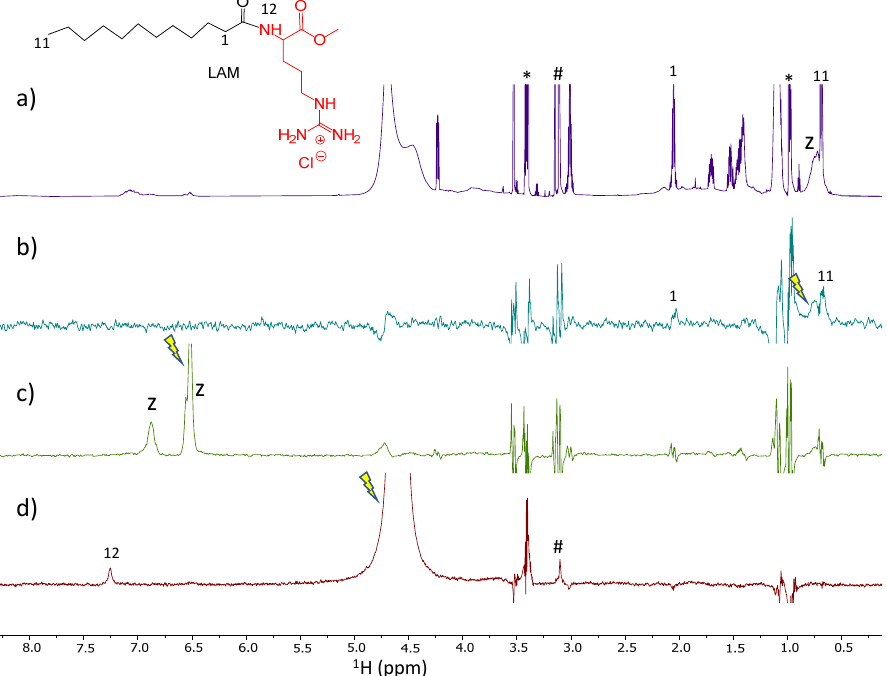
Figure 6. Spectra of LAM and zein mixture. ( a ) 1 H NMR, ( b , c ) STD off-on spectra with saturation at 0.82 and 6.6 ppm, respectively and ( d ) WaterLOGSY (mix. 500 ms). The arrow indicates the signal that is selectively on-saturated in STD spectra or selectively inverted in waterLOGSY. The assignment is provided for some relevant protons giving STD or waterLOGSY responses. The z refers to zein peaks, the asterisk denotes protons of ethanol impurity and the ampersand denotes an unidentified impurity.